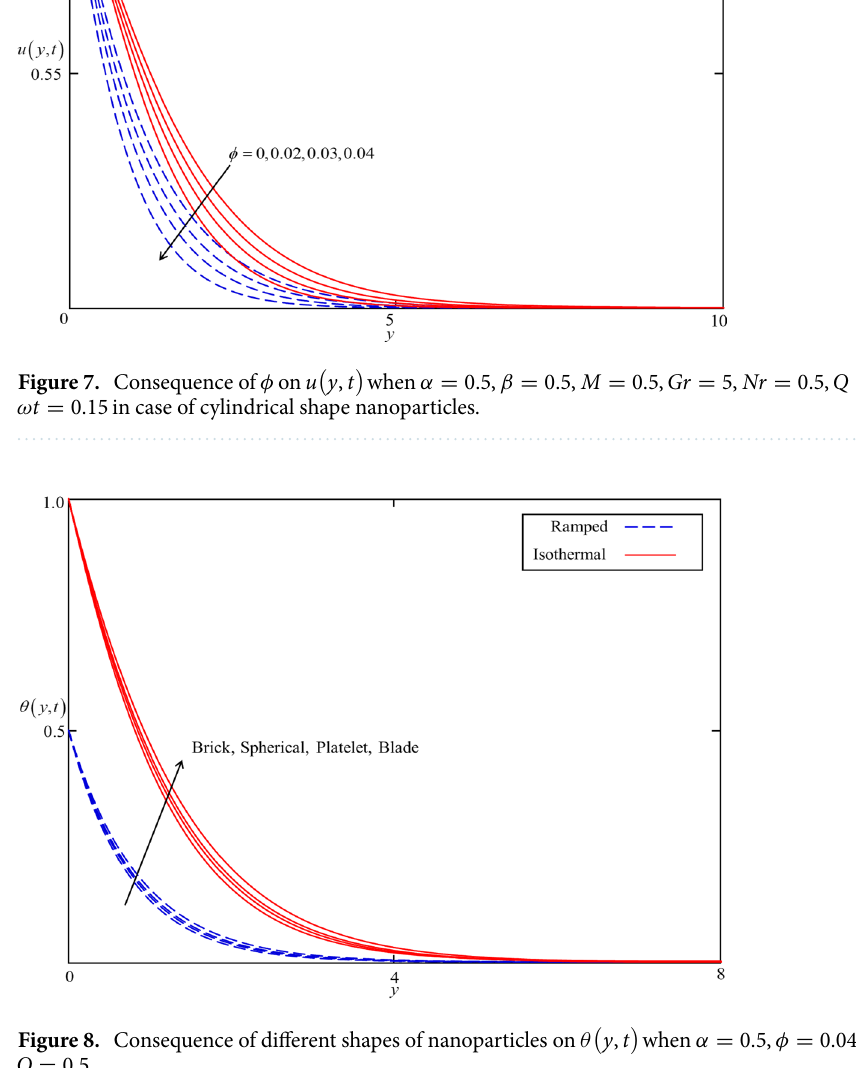
Figure 8. Consequence of different shapes of nanoparticles on θ Q =